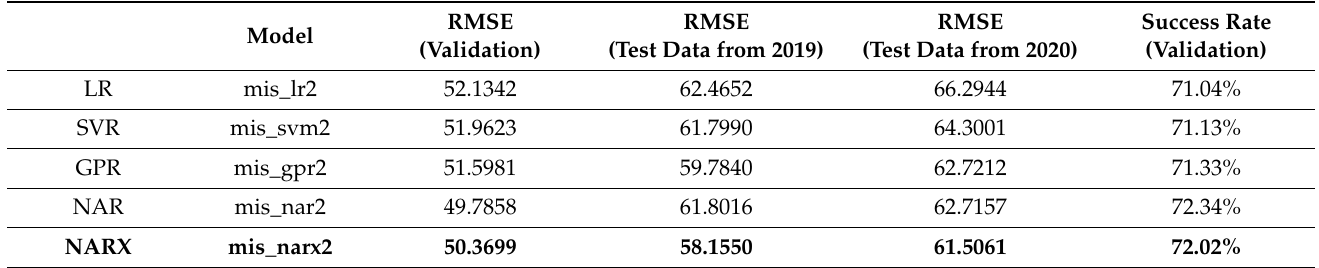
Table 7. Best model results for MIS forecasting for each ML